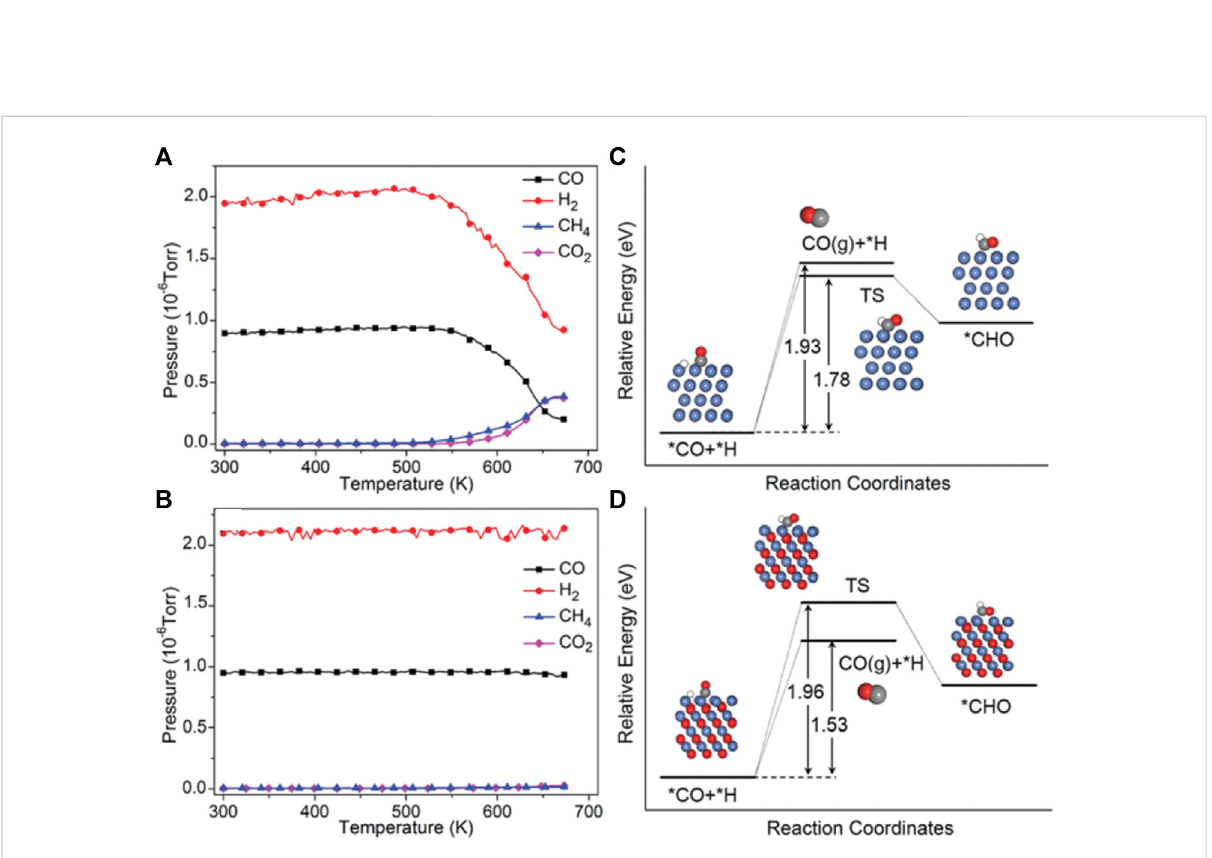
FIGURE 8 The partial pressures of CO, H 2 , CH 4 , and CO 2 during the CO hydrogenation reaction for LaNiO 3 (A) and LaFe 0.5 Ni 0.5 O 3 (B) . Potential energy diagram for the reaction routes of *CO + H on Ni (111) (C) and NiO (111) (D) . Reproduced from Zhao et al. (2018); Copyright © 2018 (Royal Society of